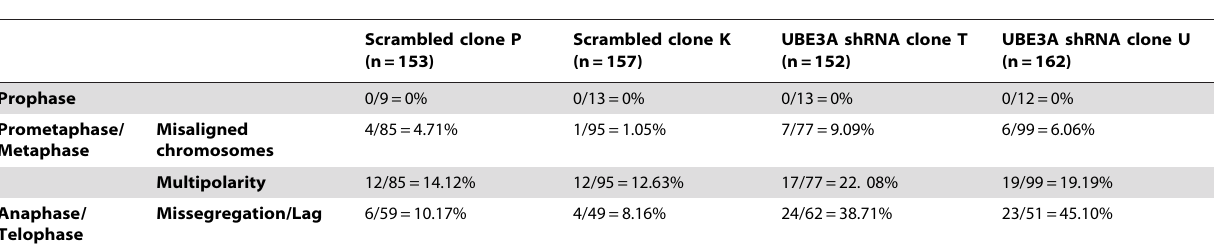
Table 1. Quantitation of mitotic abnormalities in scrambled and UBE3A shRNA knockdown